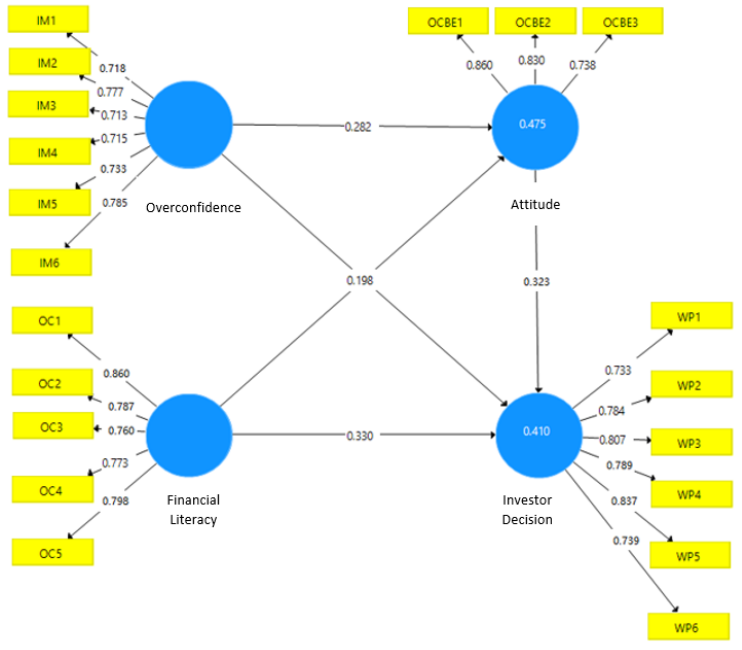
Figure 2: Measurement Model; Source: